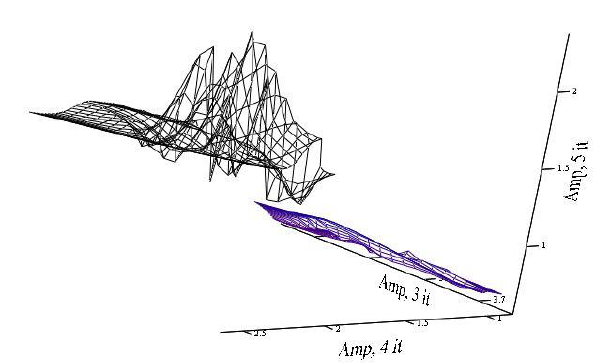
Figure 13. Autocorrelation amplitudes of the legitimate traffic (black and white plane) and the total traffic (purple plane) in three iterations (third, fourth, and fifth iteration).